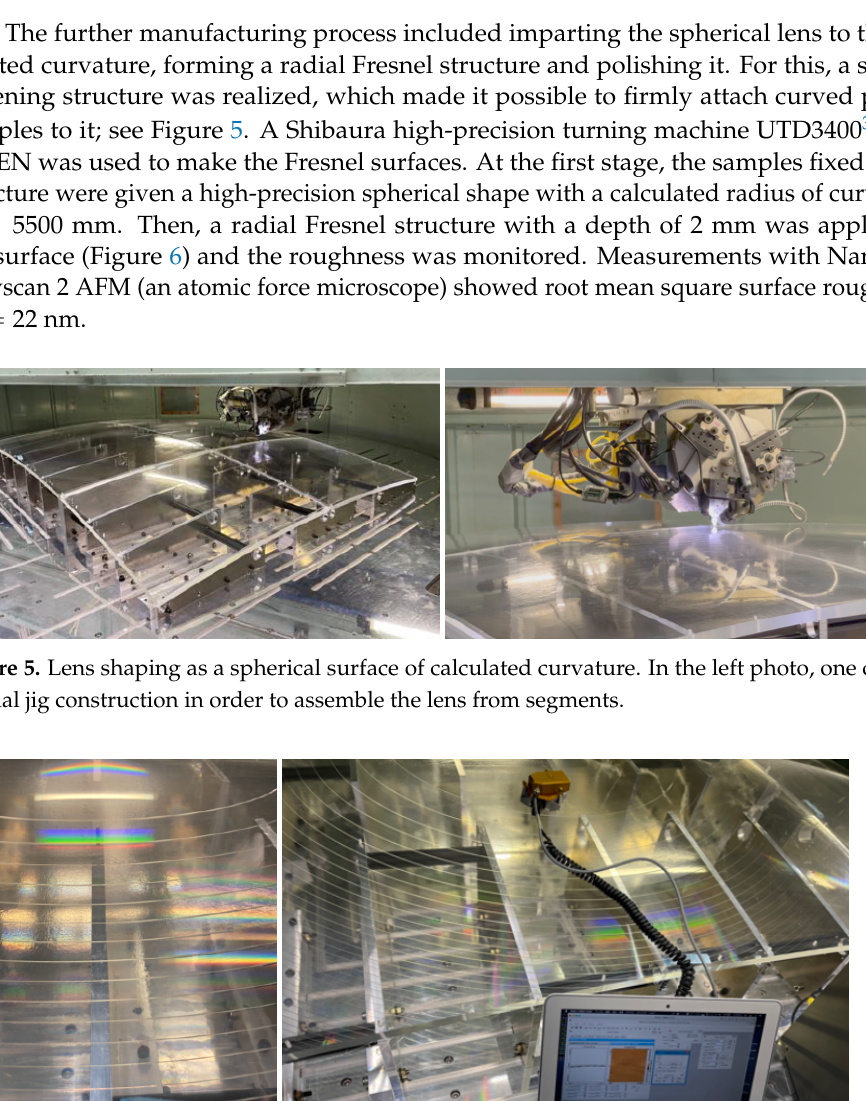
Figure 4. PMMA samples after preliminary shaping.